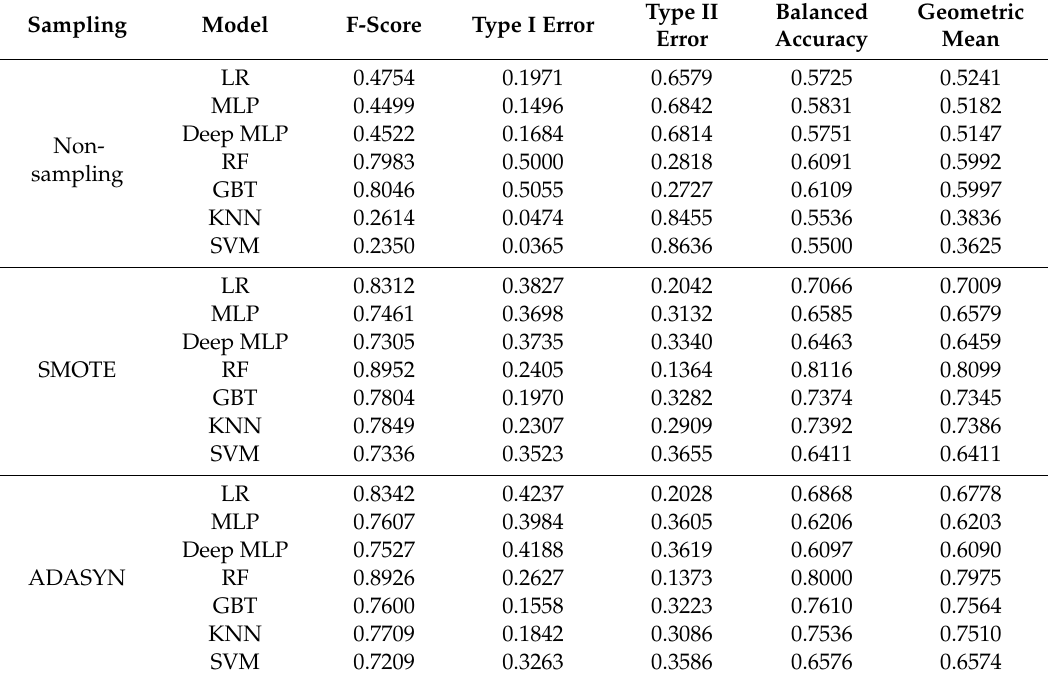
Table 4. Evaluation results of the prediction models among